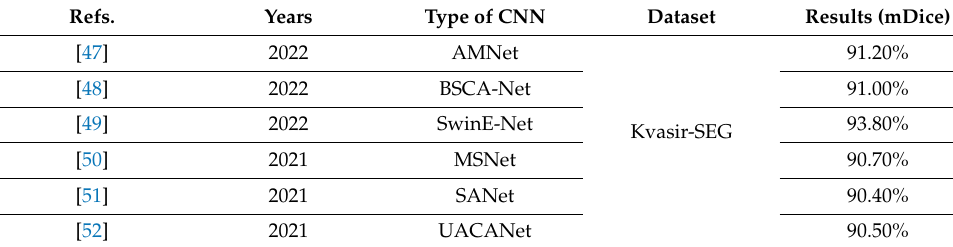
Table 1. A review of the existing models employed for polyp segmentation on the Kvasir-SEG dataset.